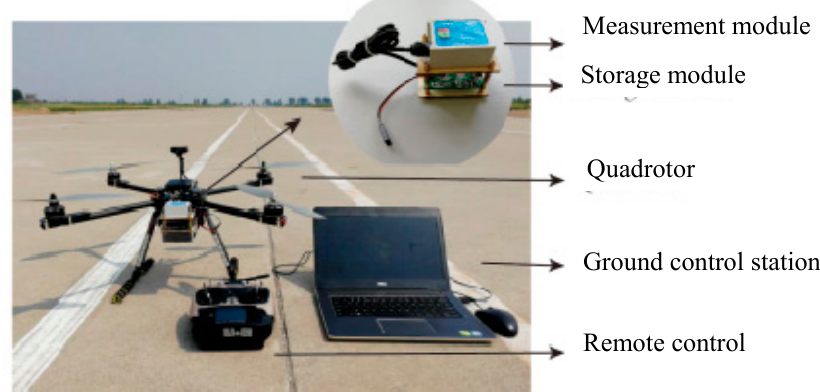
Figure 12. Experiment system of INS/ integrated navigation system. Table 2. Main parameters of the sensor module.